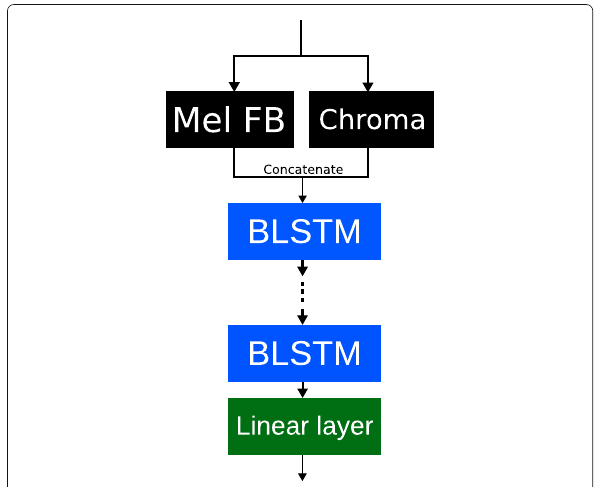
Fig. 1 BLSTM-based neural architecture description for the baseline RNN classifier